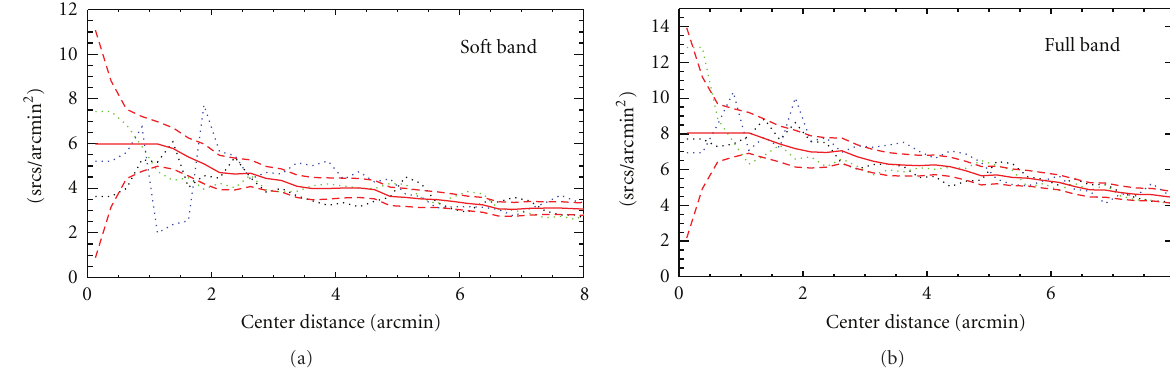
Figure 4: Background model as a function of center distance for the detected sources in the soft band (a) and the full band (b). The red solid line shows the average smoothed background model with 1 σ uncertainties indicated by the red dashed lines, whereas the colored dotted lines show the extracted counts in the three control fields. The gradual decline as a function of o ff -center angle reflects the radial change in e ff ective exposure time as shown in Figure